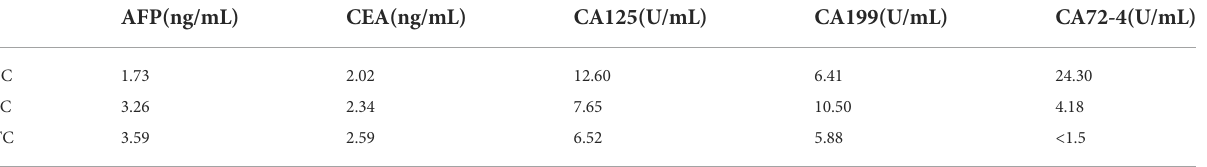
TABLE 4 Changes in tumor markers during neoadjuvant therapy